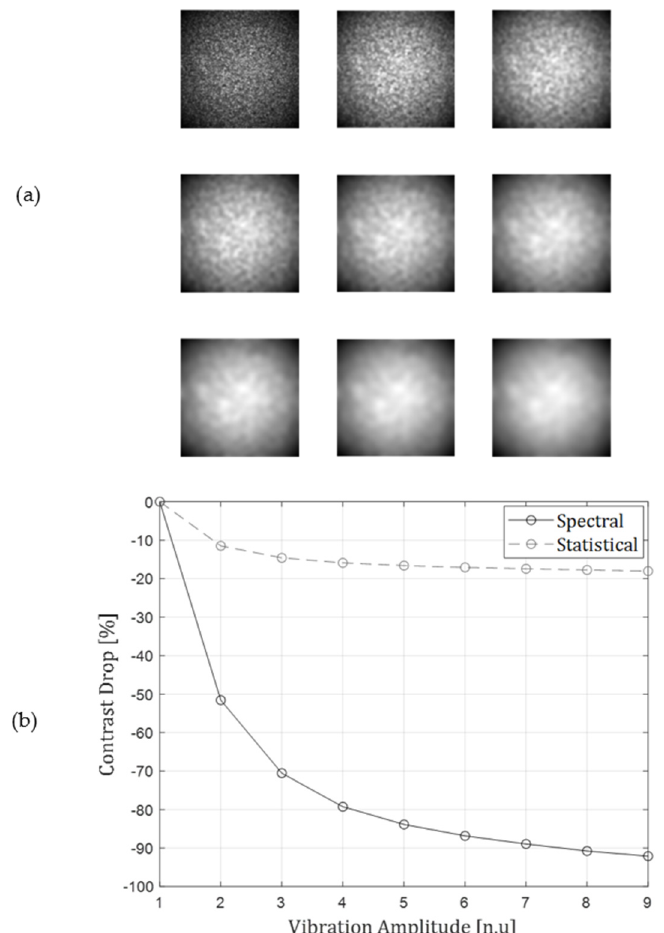
Figure 3. Contrast estimation method response to a non-uniform intensity distribution. ( a ) A set of speckle images similar to the ones presented in Figure 2, only this time not with uniform illumination, but a gaussian intensity distribution. ( b ) The corresponding contrast values for the set of patterns from both estimation methods.